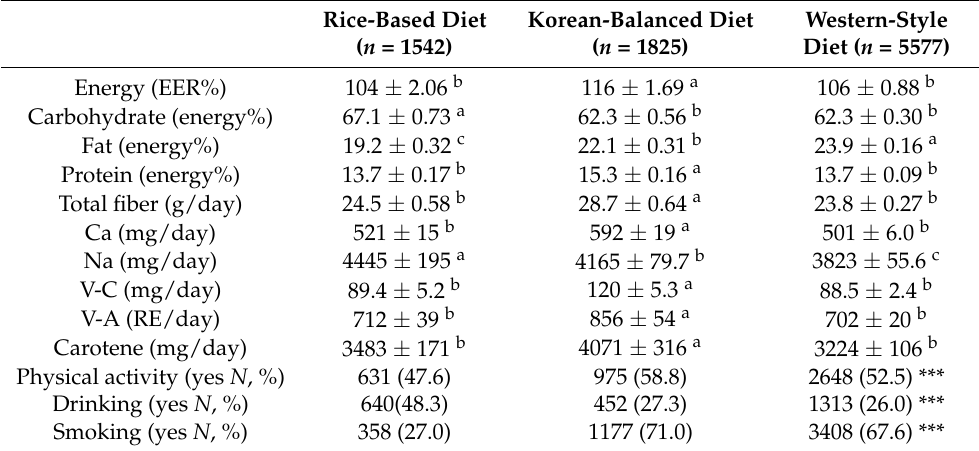
Table 2. Nutrient intake calculated from semi-quantitative food frequency questionnaires in three dietary